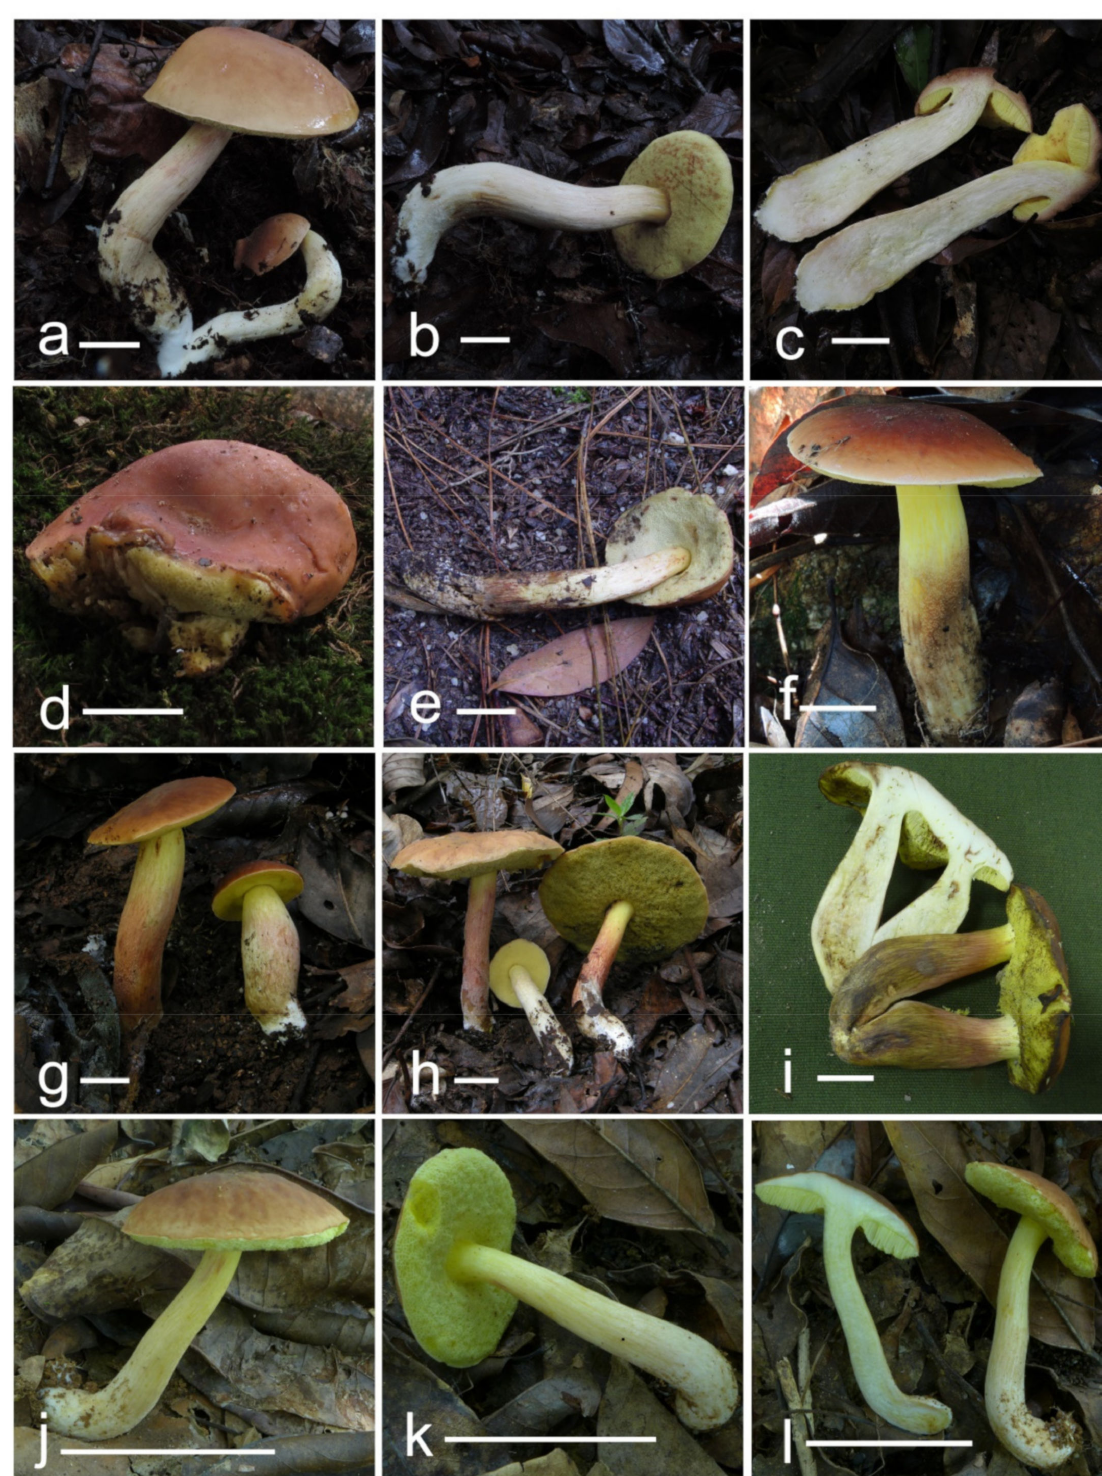
Figure 1. Fresh basidiomata of Hemileccinum species. ( a – c ) H. albidum (( a , b ) Type, KUN-HKAS81120, ( c ) KUN-HKAS87225); ( d – f ) H. brevisporum (( d ) KUN-HKAS67896, ( e ) KUN-HKAS59445, ( f ) Type, KUN-HKAS89150); ( g – i ) H. ferrugineipes (( g , h ) Type, KUN-HKAS115554, ( i ) KUN-HKAS75054); ( j – l ) H. parvum (( j – l ) Type, KUN-HKAS115553) Bars = 30